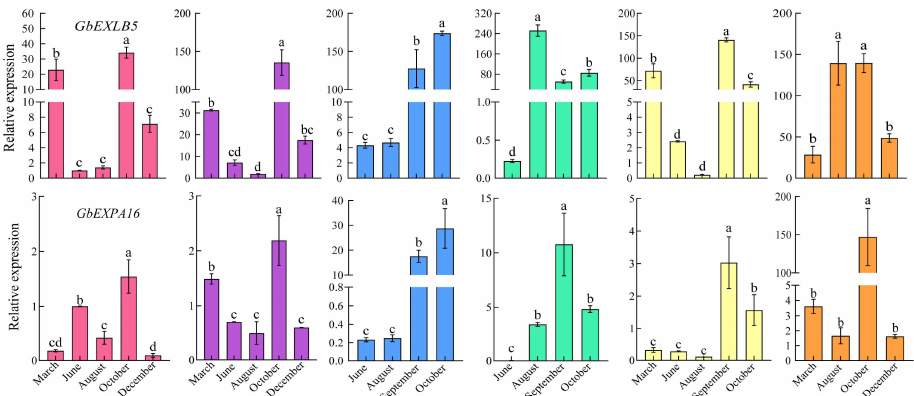
Figure 6. Relative expressions of GbEXPs in Ginkgo developing tissues. Lowercase letters indicate significant differences at p < 0.05 according to Duncan’s test (values are the means ± SDs of three independent biological